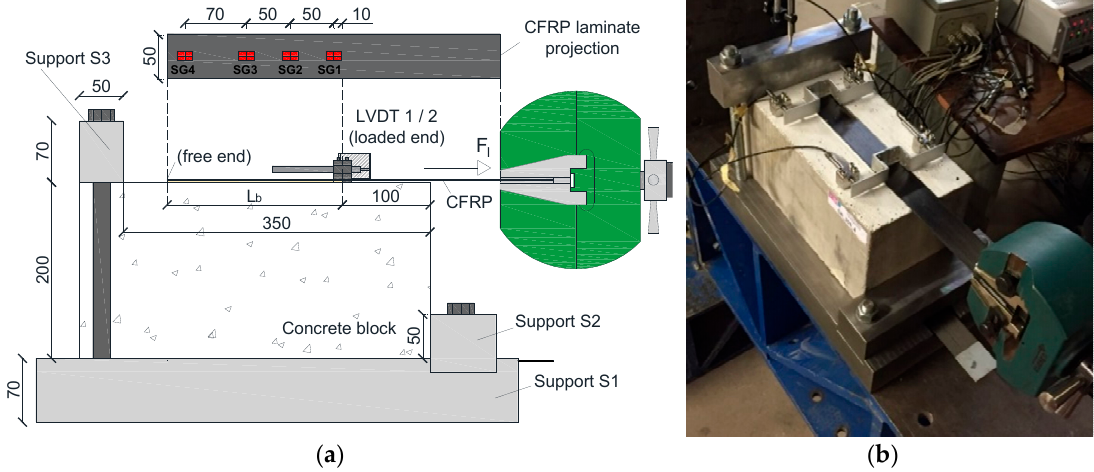
Figure 1. Experimental set-up and instrumentation: ( a ) scheme; ( b ) photo. Note: units in [mm].